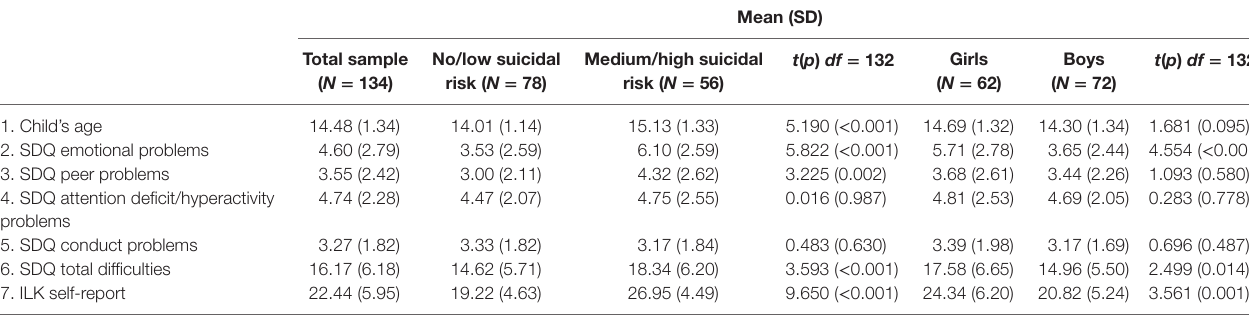
TaBle 2 | Descriptive statistics of study variables for the total sample and for no/low and medium/high suicidal risk and gender subgroups.